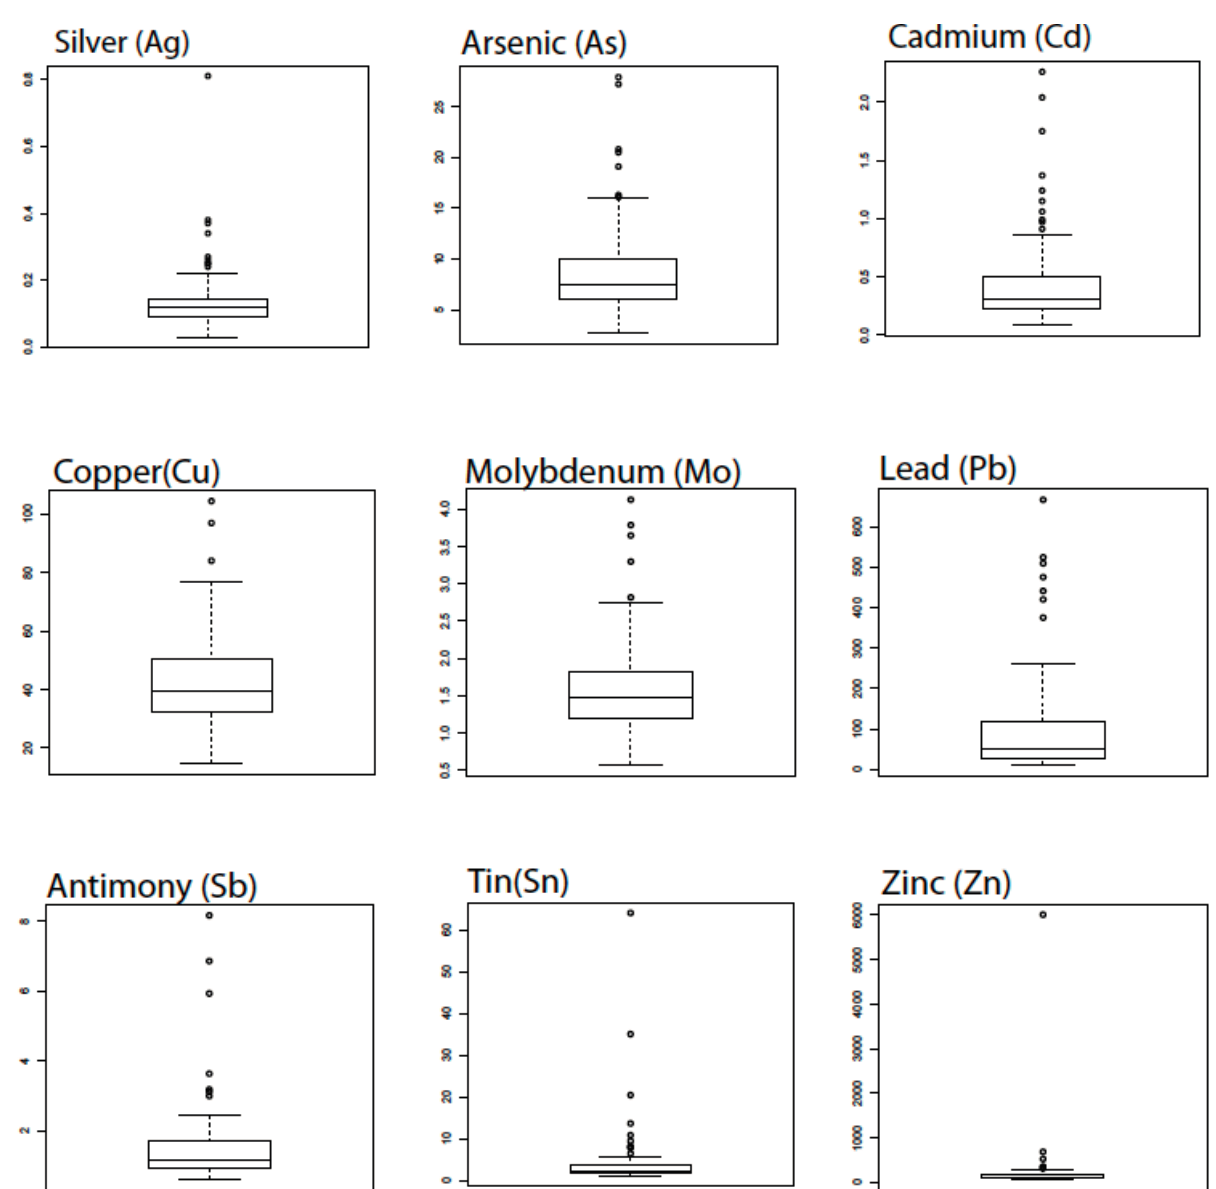
Figure 2. Boxplots of metal concentrations in mg/kg (or parts per million, ppm), showing non-normal distributions. Non-normal distributions with positive skewness exhibit elevated concentrations occur across all background levels. This is an indication that the elevated concentrations are of anthropogenic origin. The center line represents the average data value; top and bottom box edges represent the 25th and 75th percentiles, respectively; the top and bottom whiskers mark the 10th and 90th percentiles,